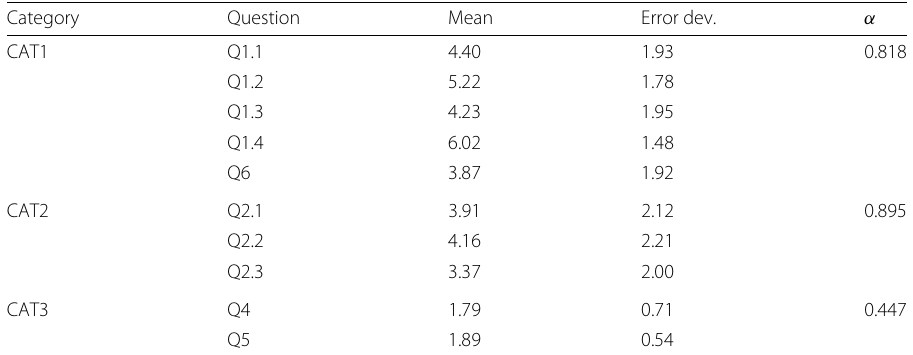
Table 1 Internal consistency measured by Cronbach’s Alpha for questionnaire replies (based on Ferreira et al.